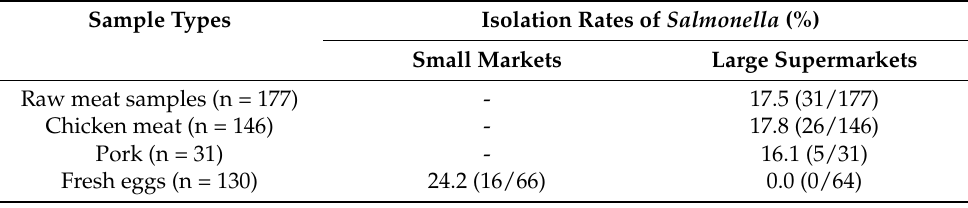
Table 1. Isolation rates of Salmonella in different types of retail